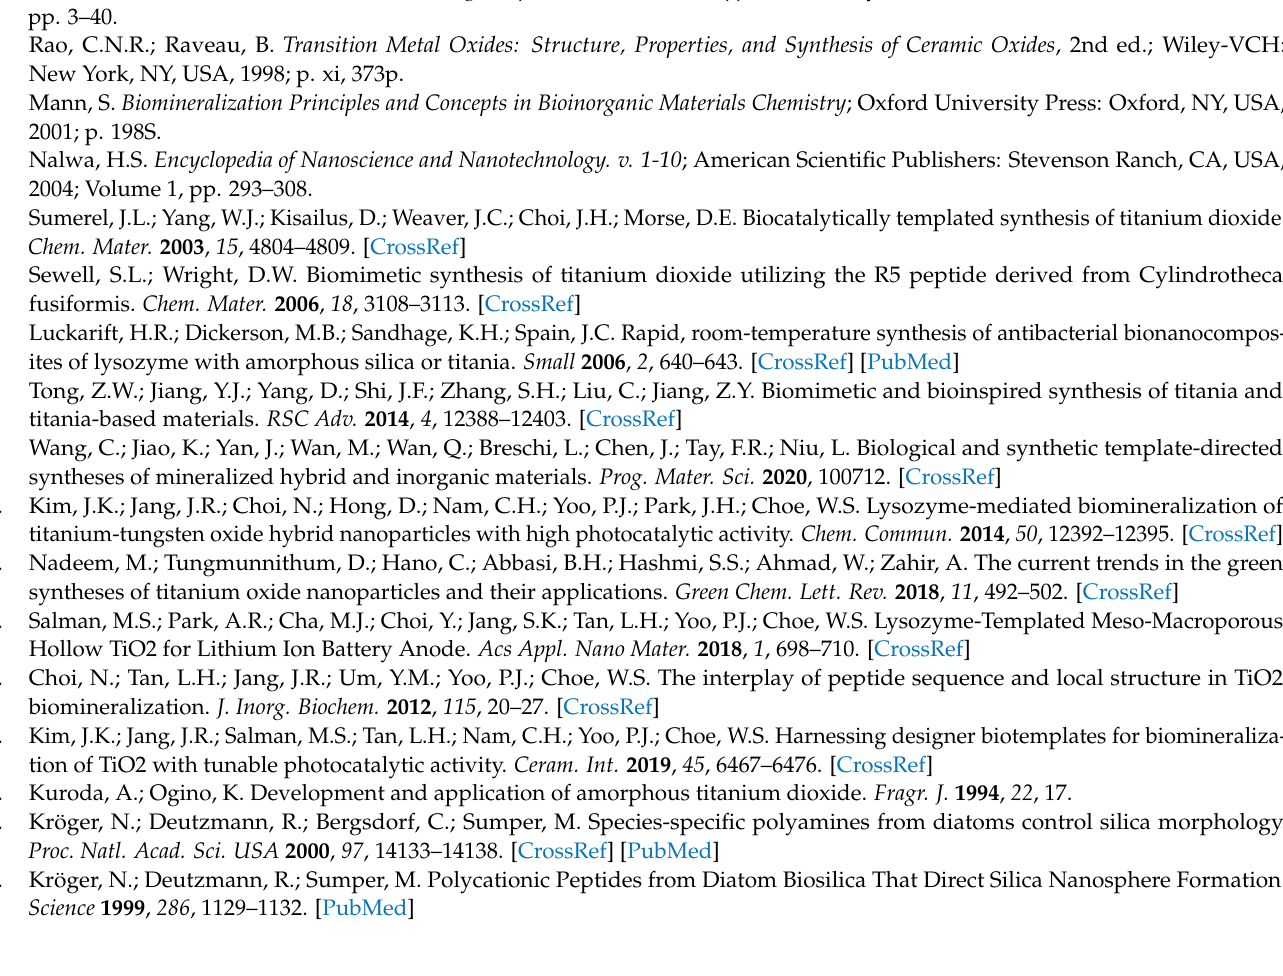
Figure S2: 1 H NMR spectra of lysozyme titration with TiBALDH. References [70,71] are refered to in Supplementary